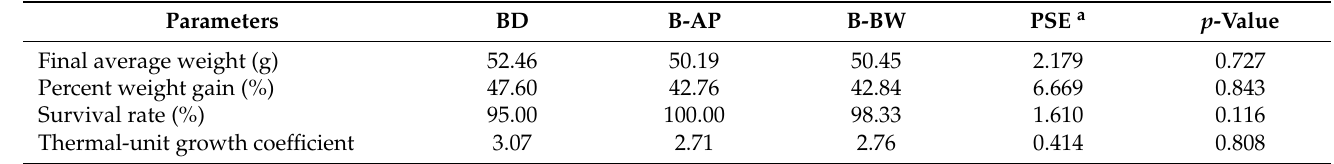
Table 4. Growth performance of channel catfish cultured in flow-through system for 6 weeks fed different probiotics, stocked at 10 fish/tank with an initial weight at 34.80 ± 12.53 g (Mean ± SEM).